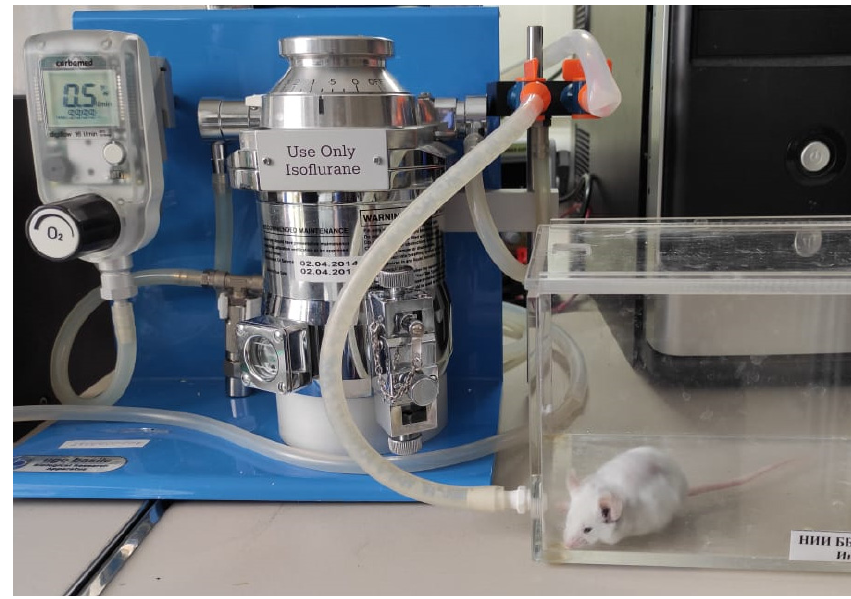
Figure 1. Anesthetized mice by isoflurane using the Ugo Basile gas anesthesia system.